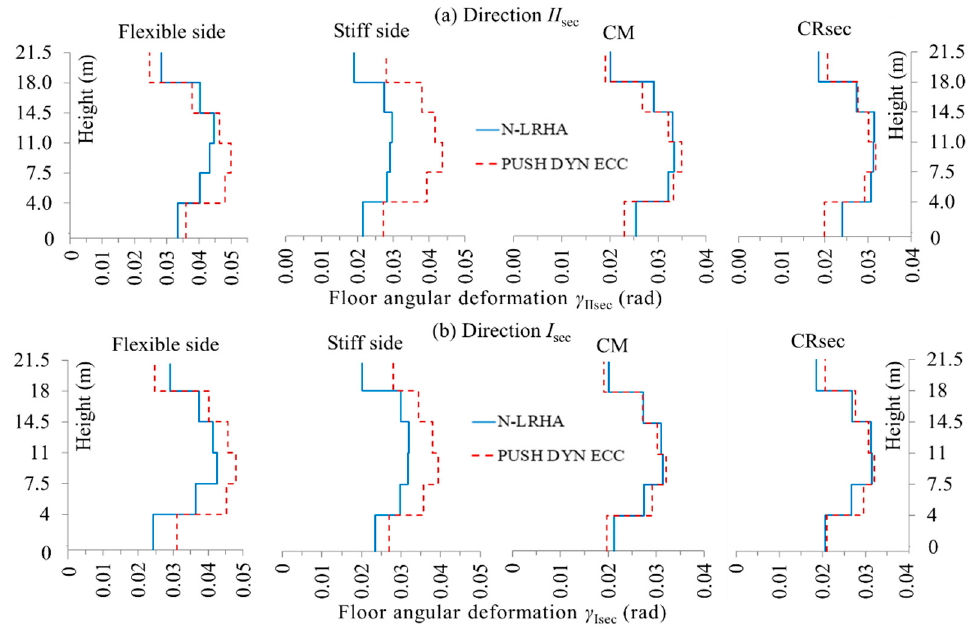
Figure 13. Floor angular deformations (rad) of case 1 building at NC: ( a ) γ IIsec along the II sec axis, ( b ) γ Isec along the I sec axis. Proposed pushover procedure vs. N-LRHA.